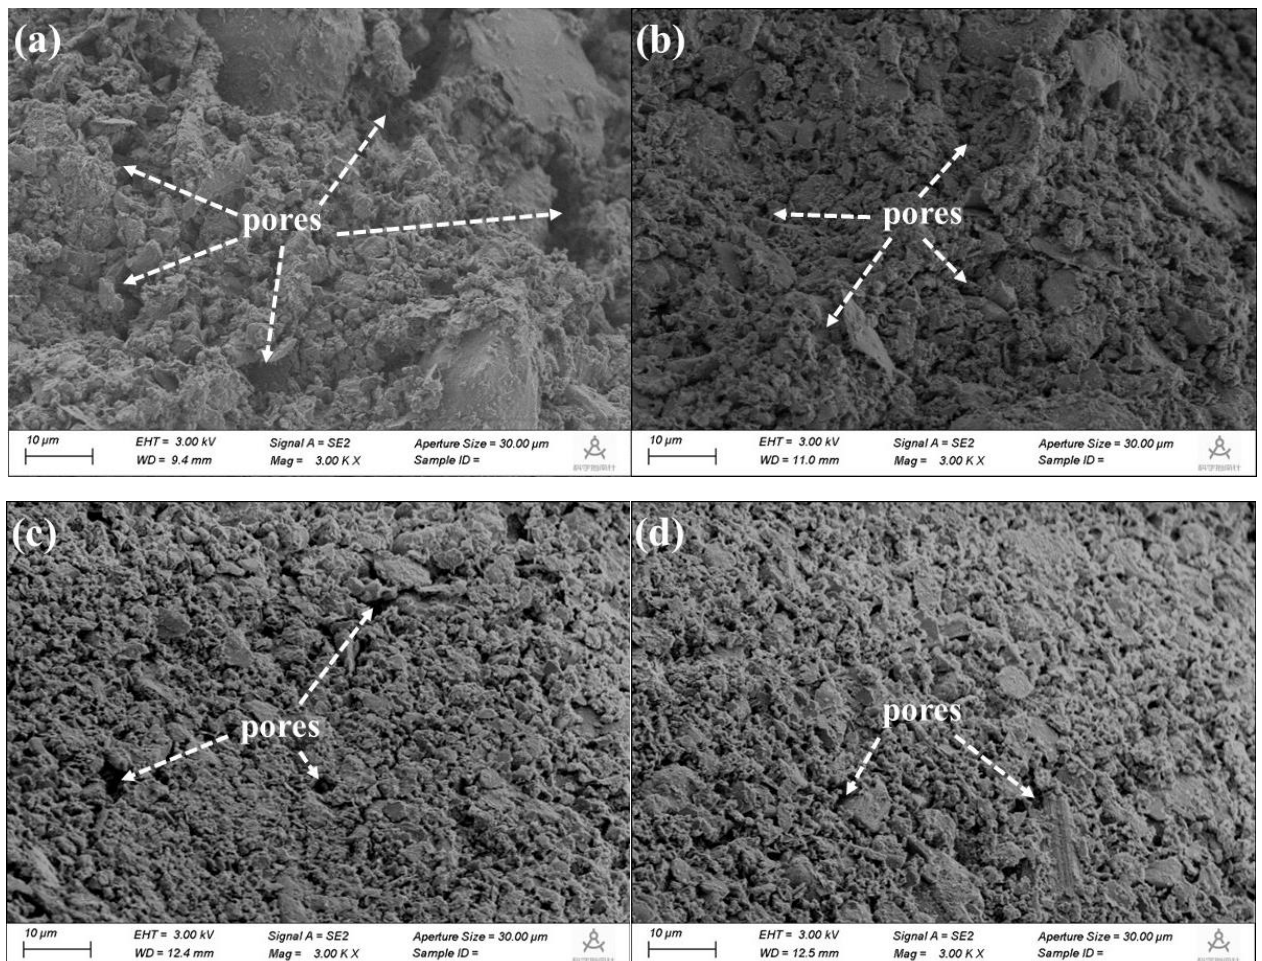
Figure 19. Microstructure of TS ( a ), MTS-10 ( b ), MTS-30 ( c ), and MTS-50 ( d ). Figure 19a indicates that the samples in the TS group exhibited a loose microstructure with pore space between the particles. A small amount of calcium carbonate and calcium